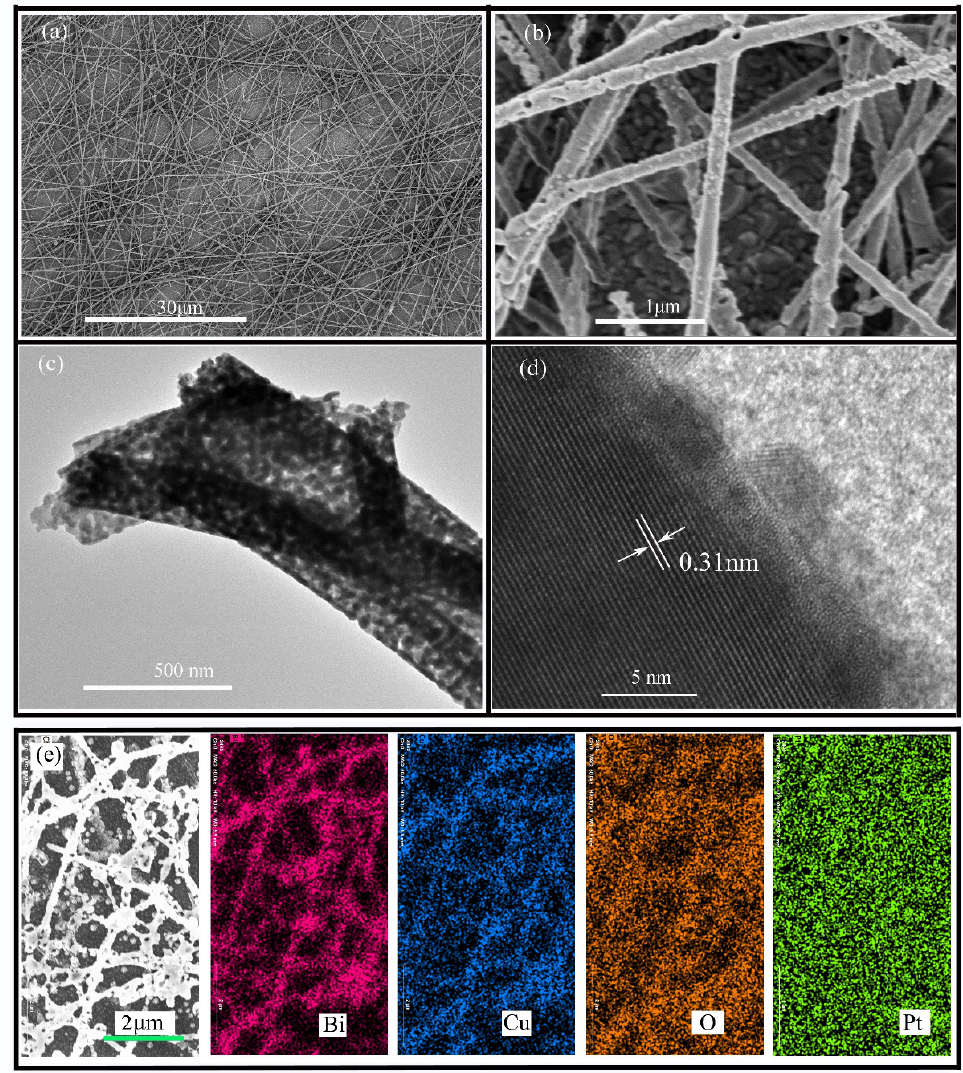
Figure 2. The CuBi 2 O 4 nanofibers’ ( a , b ) SEM images and ( c,d ) TEM images; ( e ) the elemental mapping after depositing